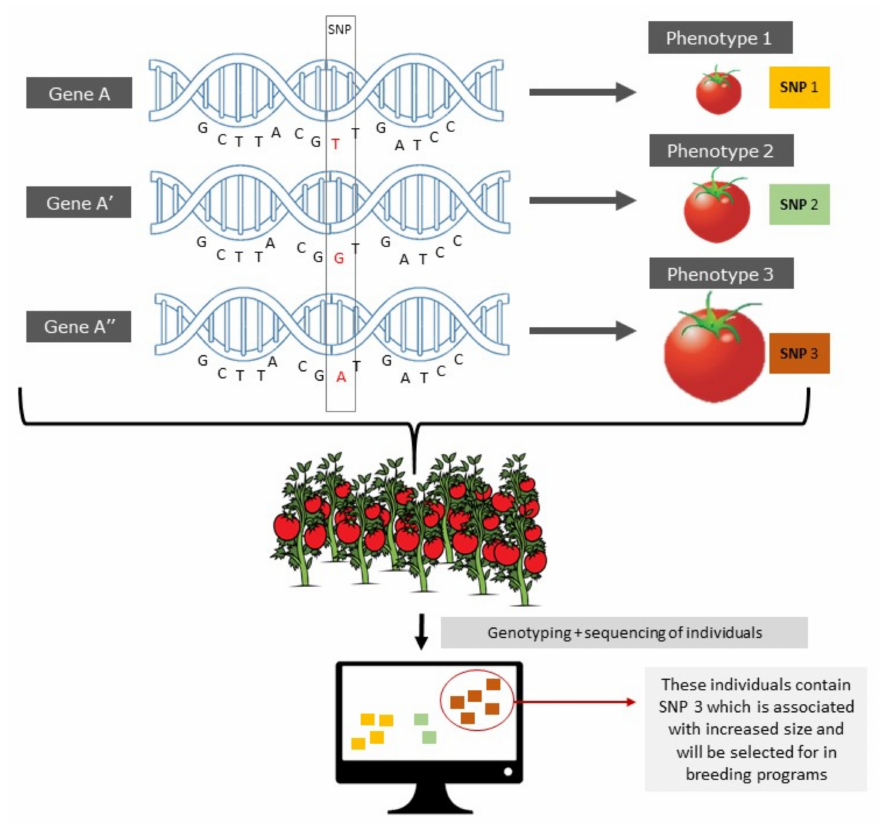
Figure 1. Marker-assisted selection of a quantitative trait in tomato using a SNP